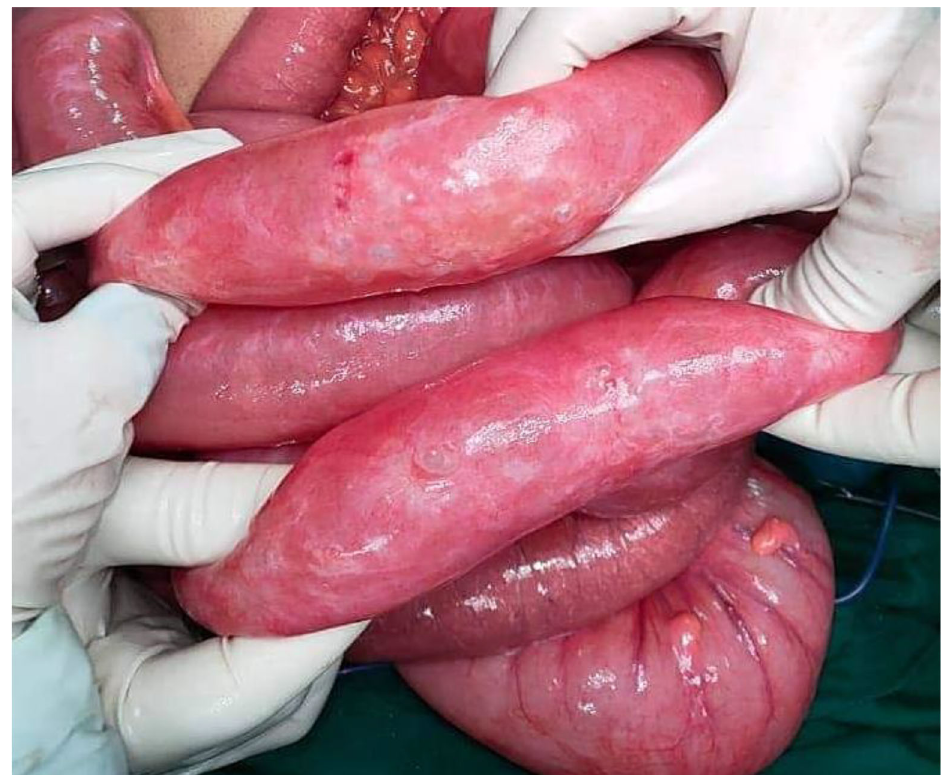
Figure 8. Segmental pneumatosis intestinalis involving the ileal